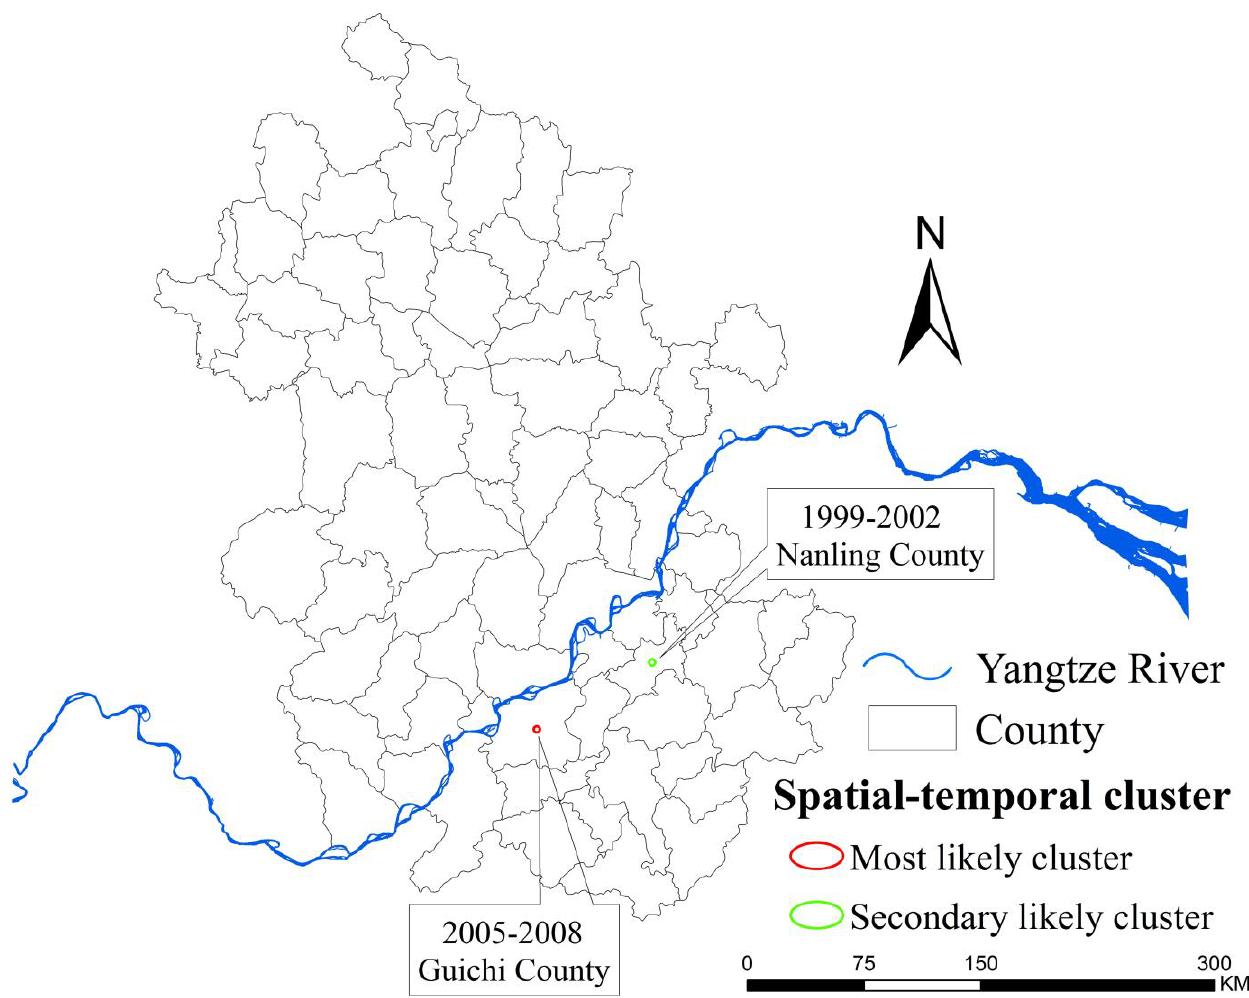
Figure 5. Location of spatial-temporal clustering. The maps were created using the ArcGIS 10.0 software (ESRI Inc., Redlands, CA,